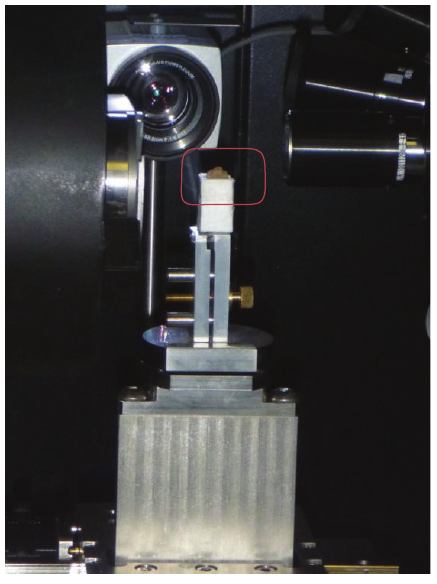
Figure 4: CT Scanner (Xradia CTX 400) with